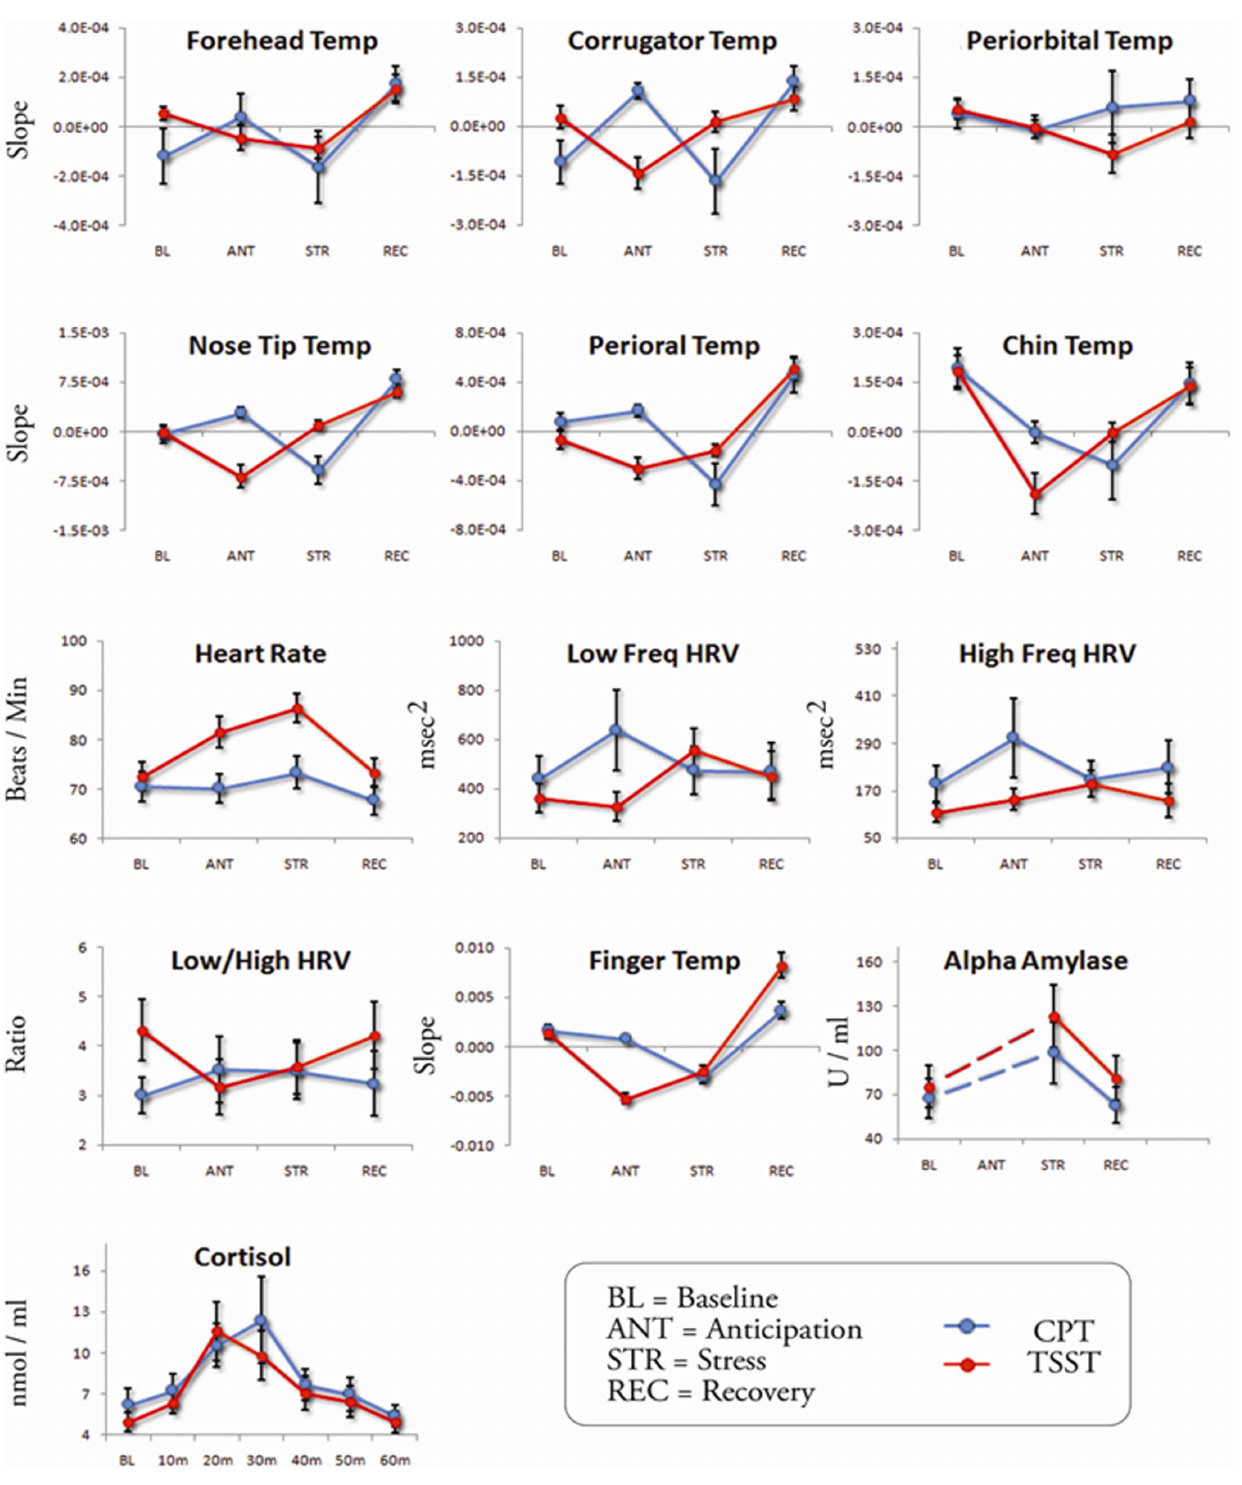
Figure 3. Means and ± SEM of all dependent variables (raw or logged scores) during baseline, anticipation, stress and recovery (sampling time points for alpha-amylase and cortisol) of CPT and TSST.